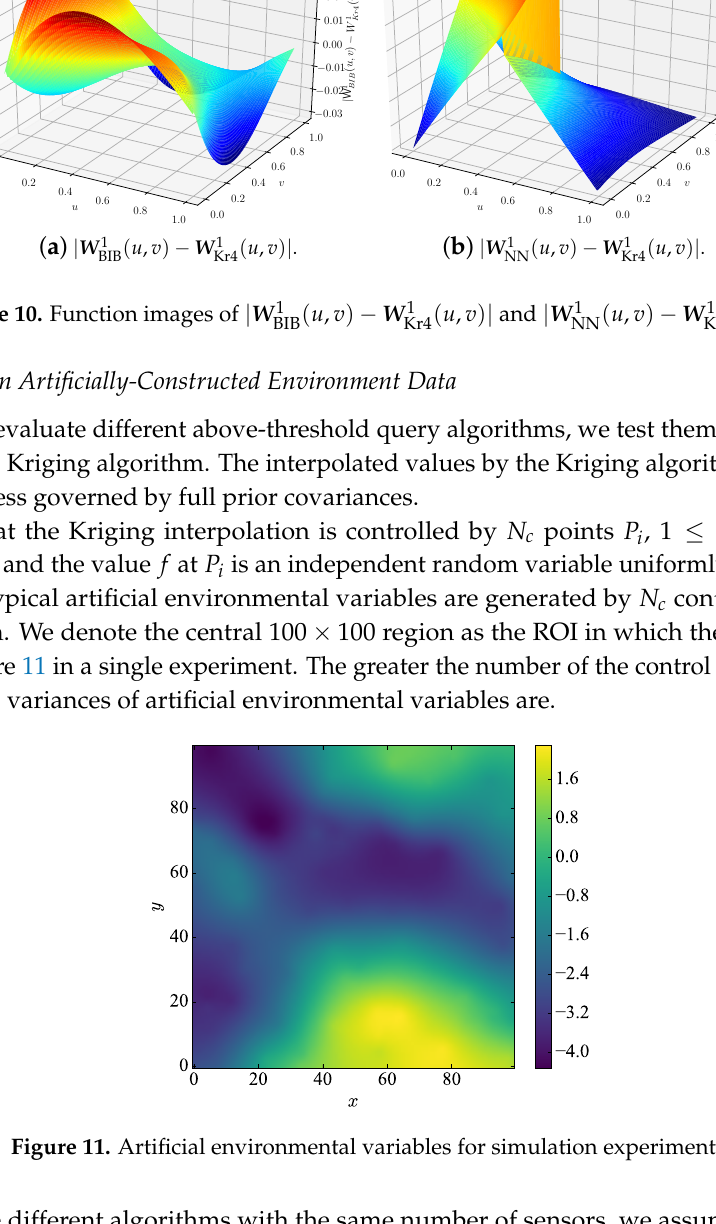
Figure 10. Function images of